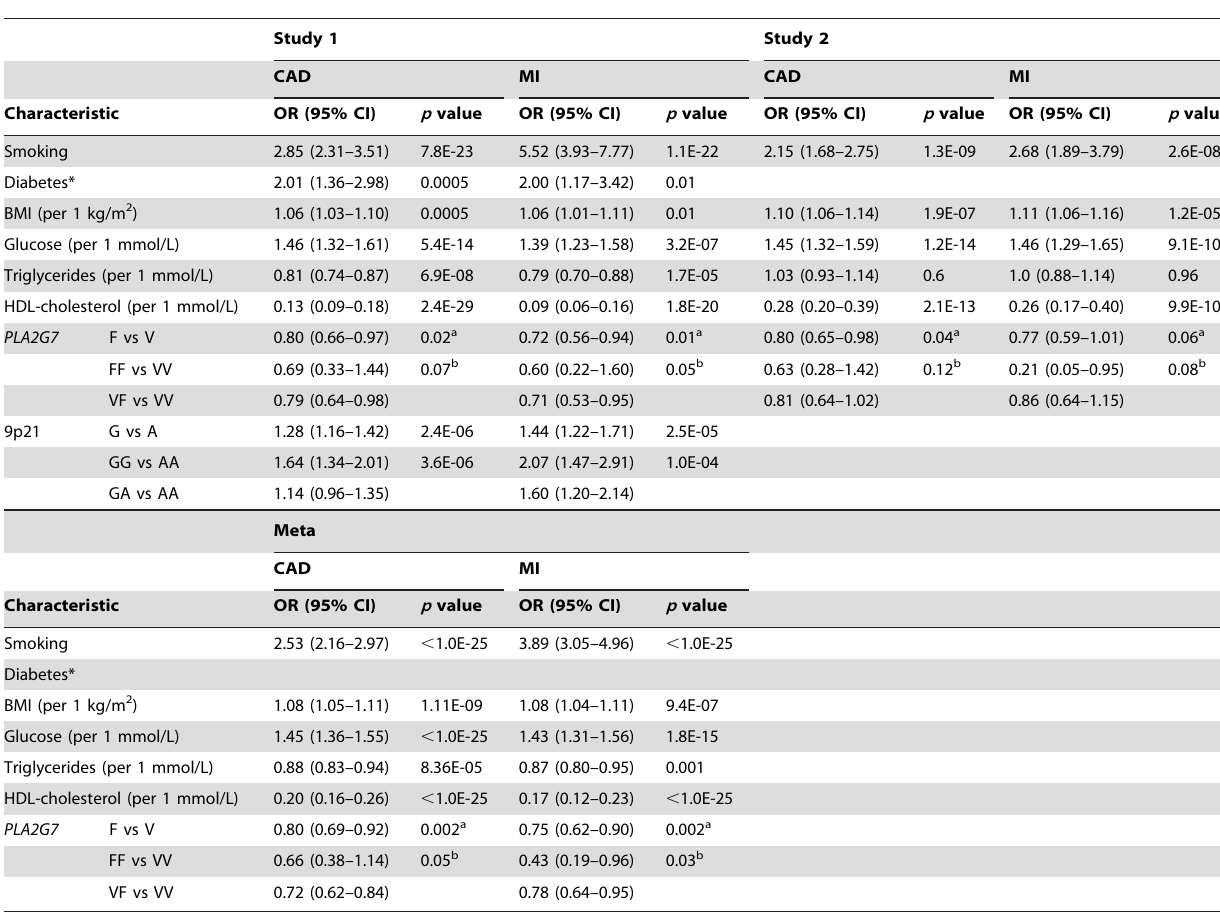
Table 3. Logistic regression model of CAD and MI in Studies 1 and